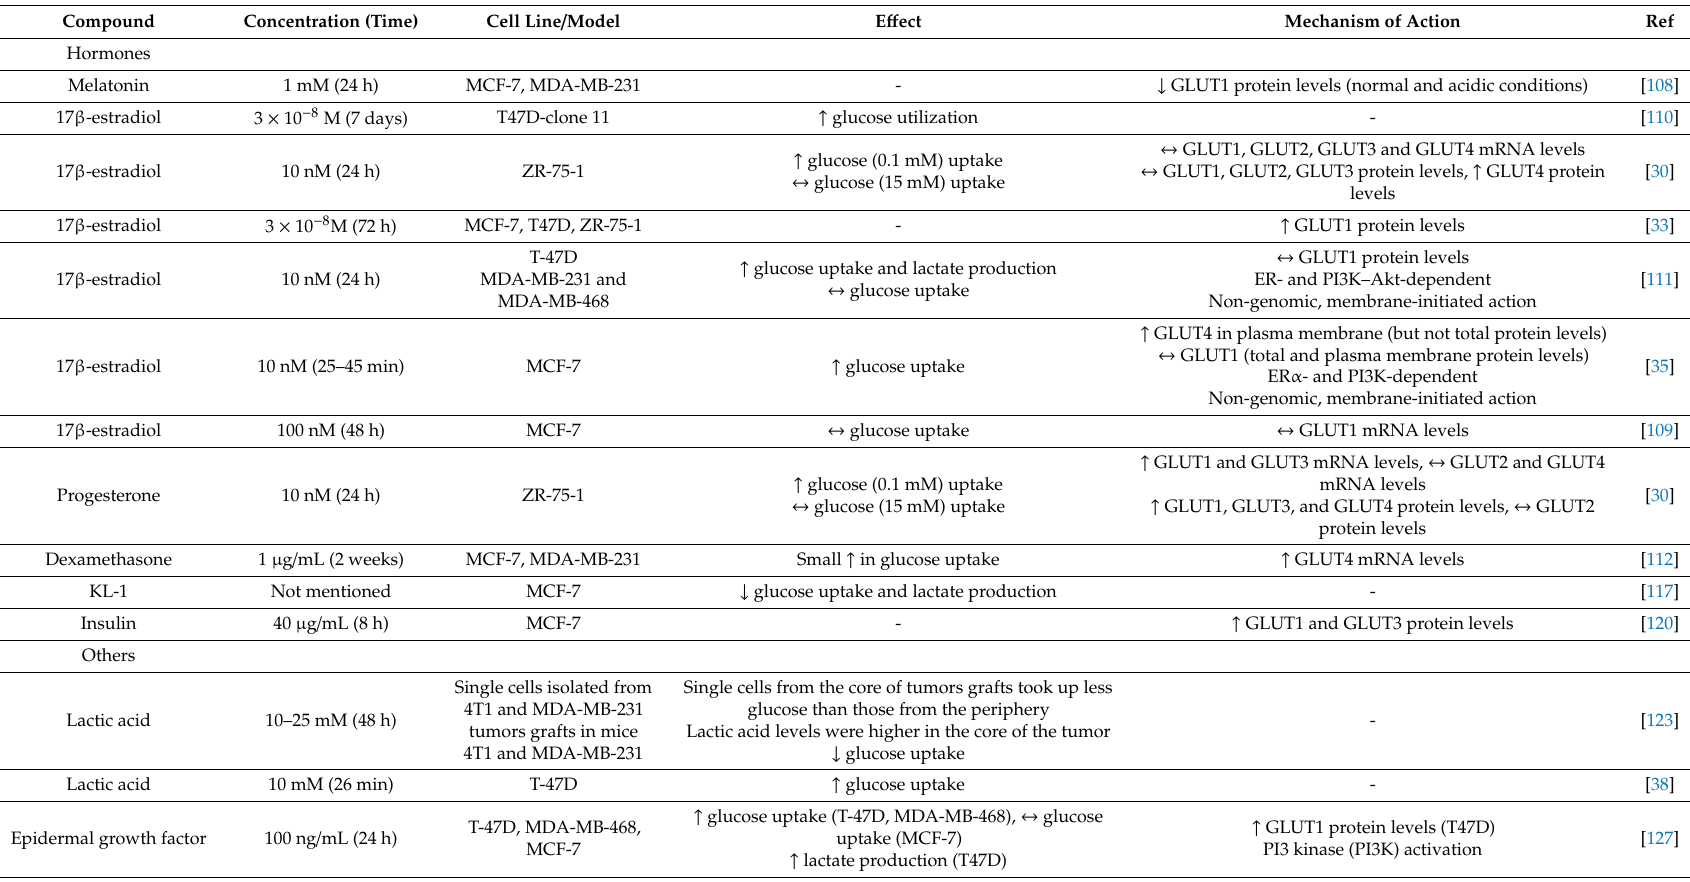
Table 2. E ff ect of endogenous compounds on glucose uptake by breast cancer